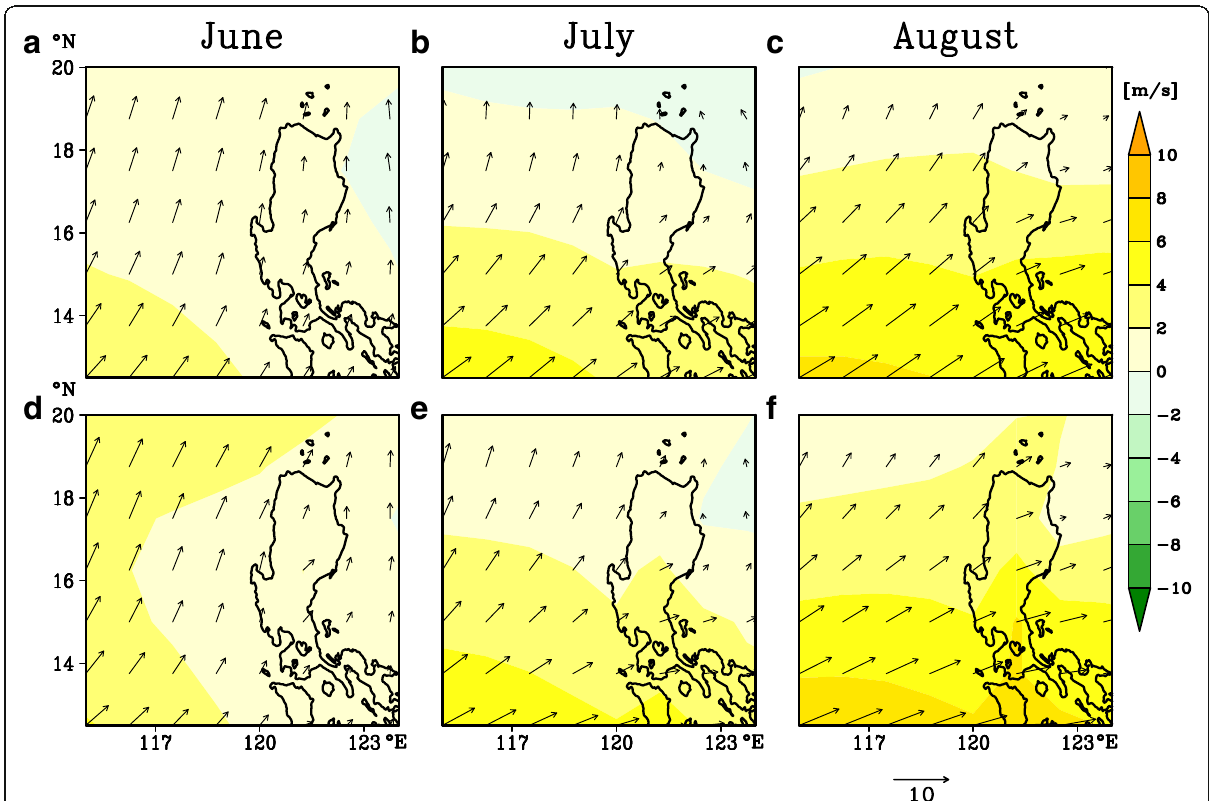
Fig. 2 Climatological monthly 850 hPa level winds (m s − 1 ) from 1982 to 2012 over domain 2, calculated by the CTL simulation ( d – f ) and compared with the JRA55 ( a – c ). Monsoon strength, denoted by the zonal wind component, is shown as shaded contours in the